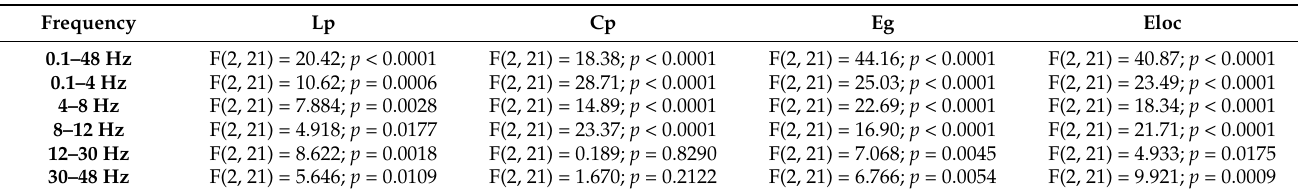
Figure 8. The differences in the strength of functional brain connections in three groups at different stages. Table 2. Intergroup comparisons of brain